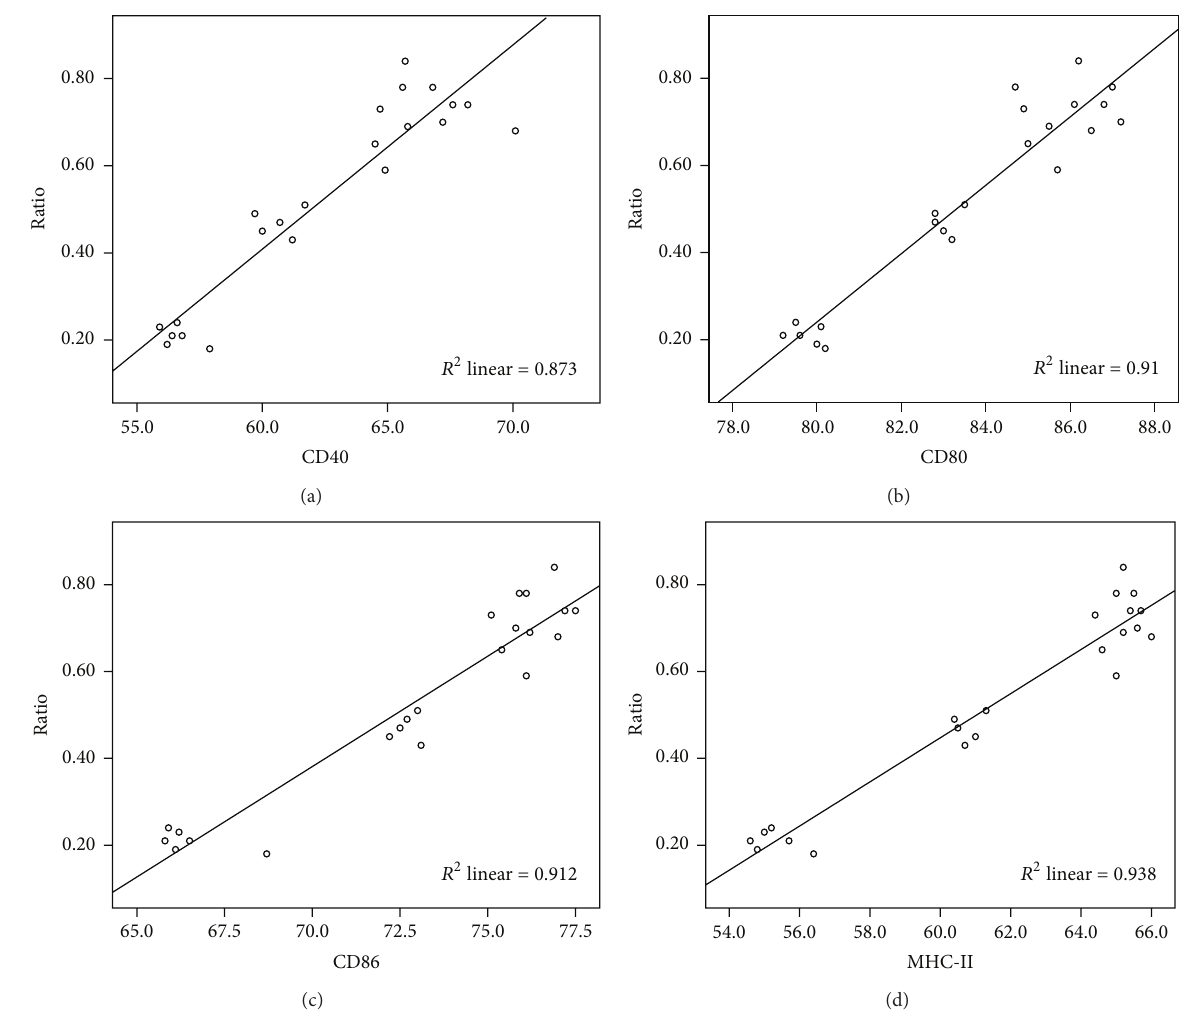
Figure 8: The correlation scatter plot of Th17/Treg ratio and DC surface antigen CD40 ( 𝑟 = 0.862 , 𝑃 < 0.001 ), CD80 ( 𝑟 = 0.855 , 𝑃 < 0.001 ), CD86 ( 𝑟 = 0.865 , 𝑃 < 0.001 ), and MHC-II ( 𝑟 = 0.860 , 𝑃 < 0.001